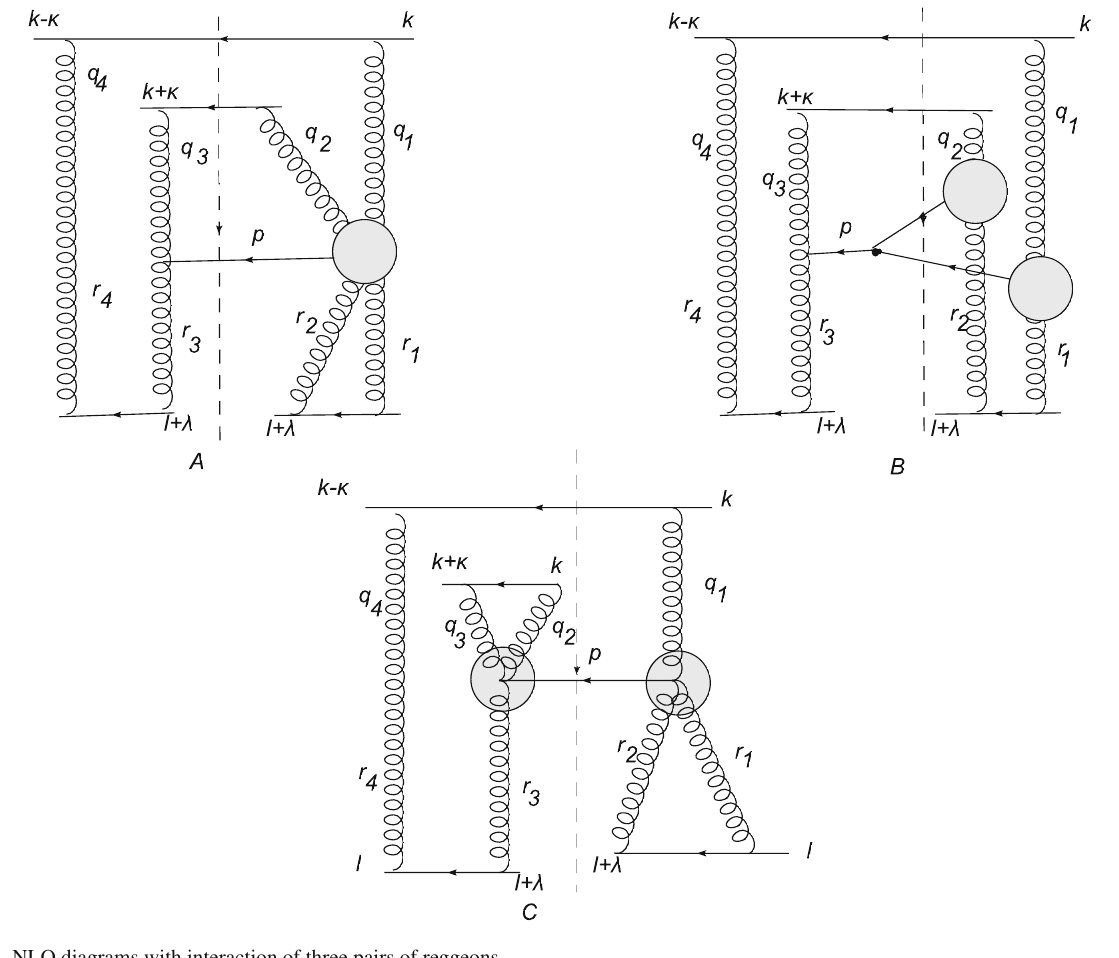
Fig. 1 NLO diagrams with interaction of three pairs of reggeons